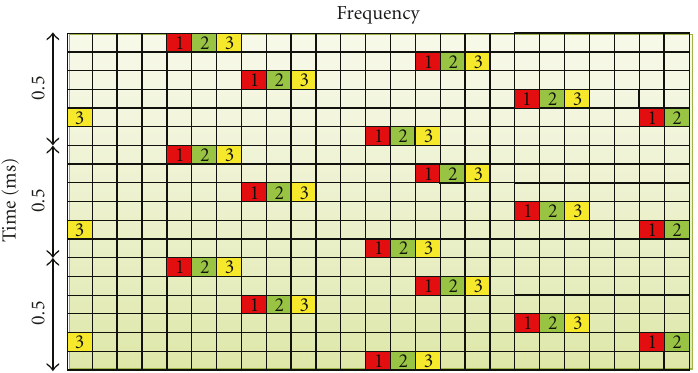
Figure 5: Time and frequency division of the physical resource